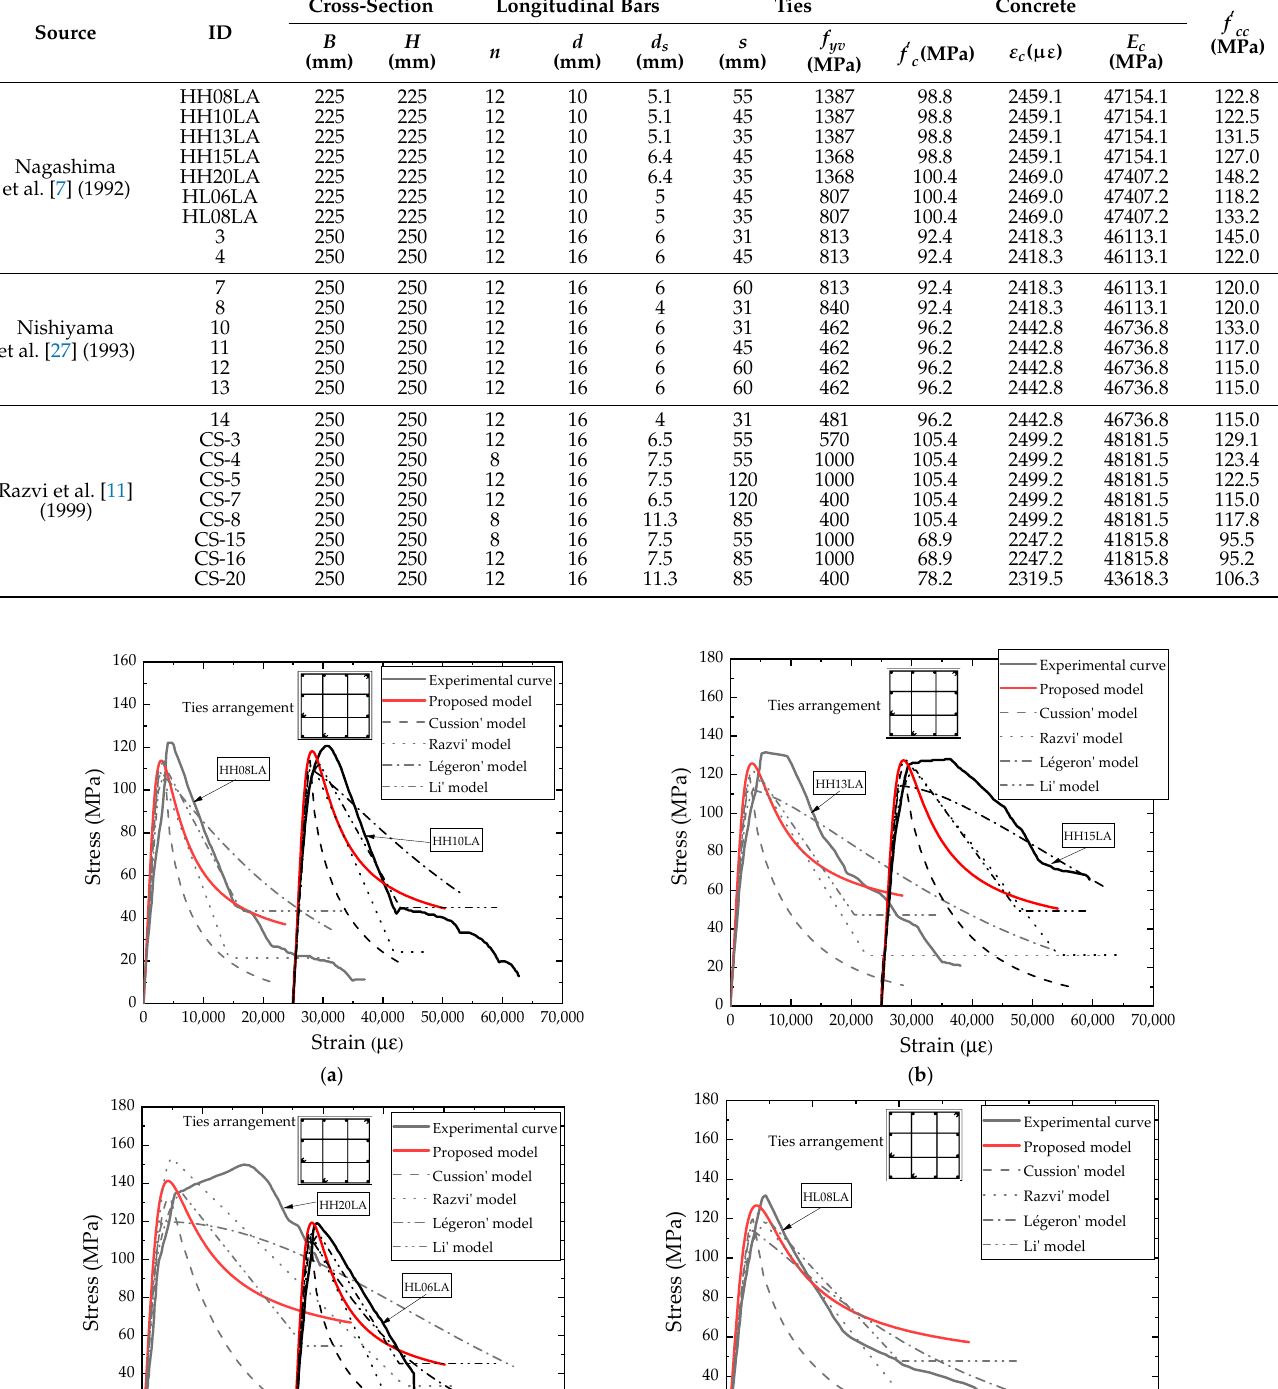
Table 3. Database for model verification.